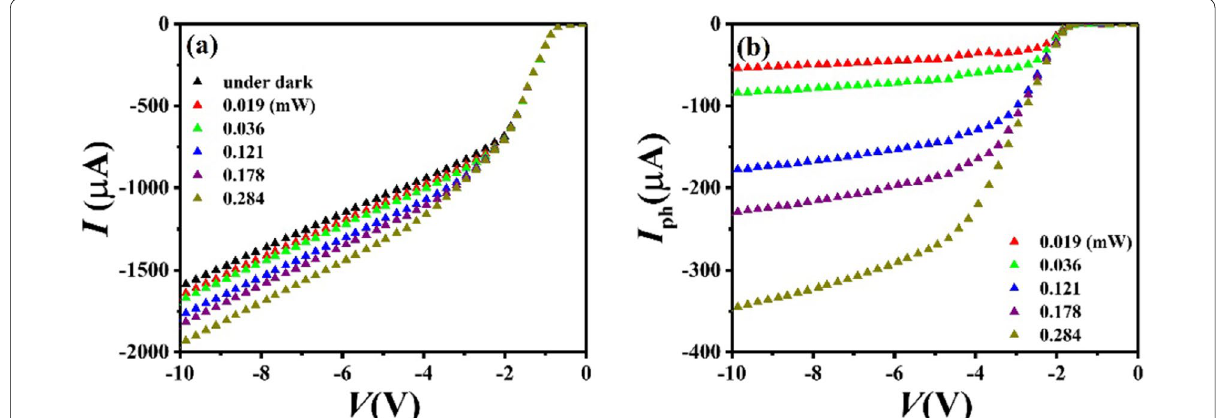
Fig. 3 a The I – V characteristics of the device Si/PTCDA:CuPc (30 nm)/Au in the dark and under 532 nm laser illumination with different optical power. b The dependences of photocurrent on the reverse bias voltage under 532 nm laser illumination with different optical